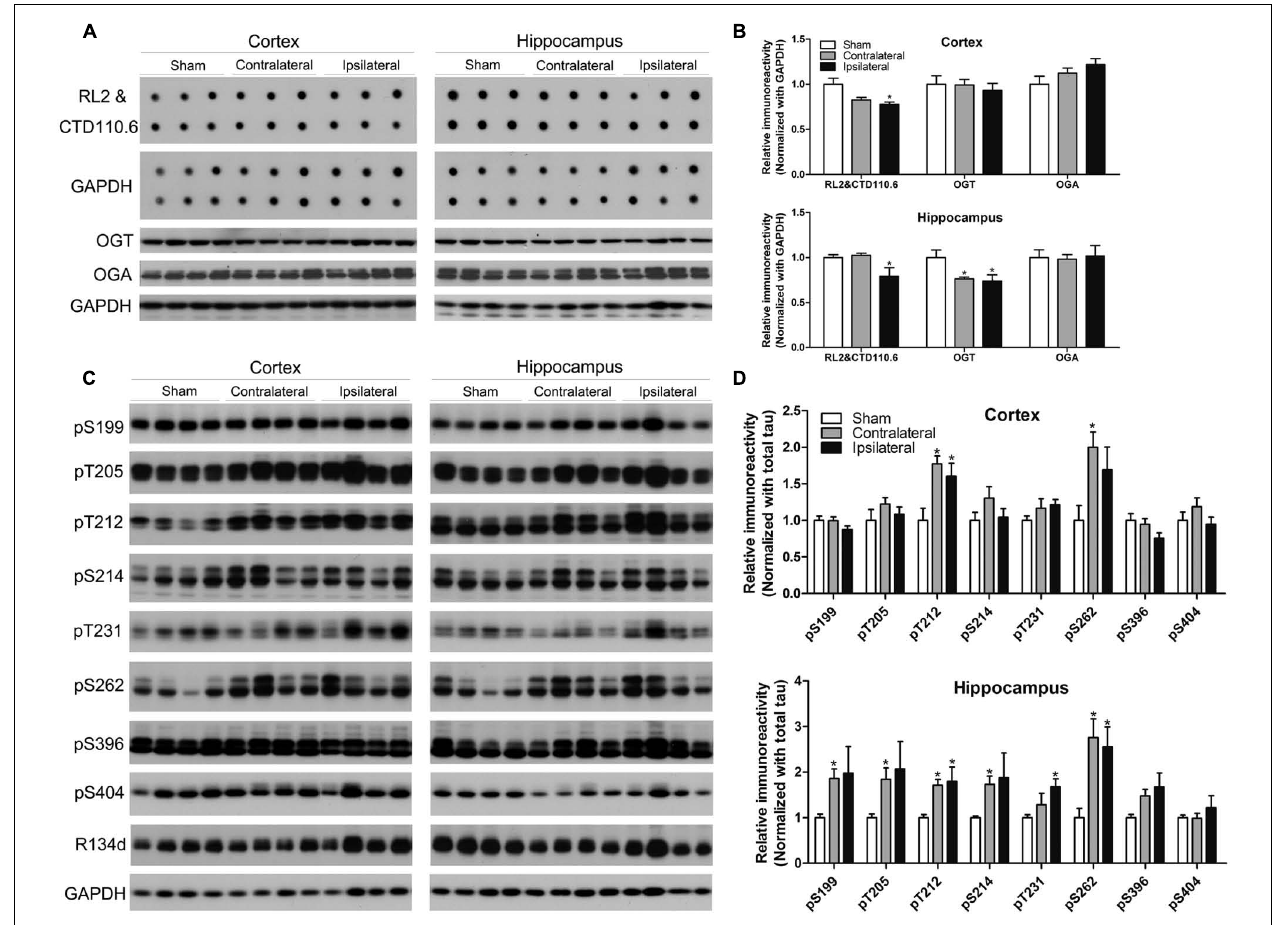
FIGURE 4 | Effects of CCH on O-GlcNAcylation and tau phosphorylation. Homogenates of the cortices and hippocampi of mice 2.5 months after sham or UCCAO surgery were analyzed by immuno-dot blots developed with a mixture of monoclonal antibodies RL2 and CTD110.6 against O-GlcNAcylated proteins and Western blots developed